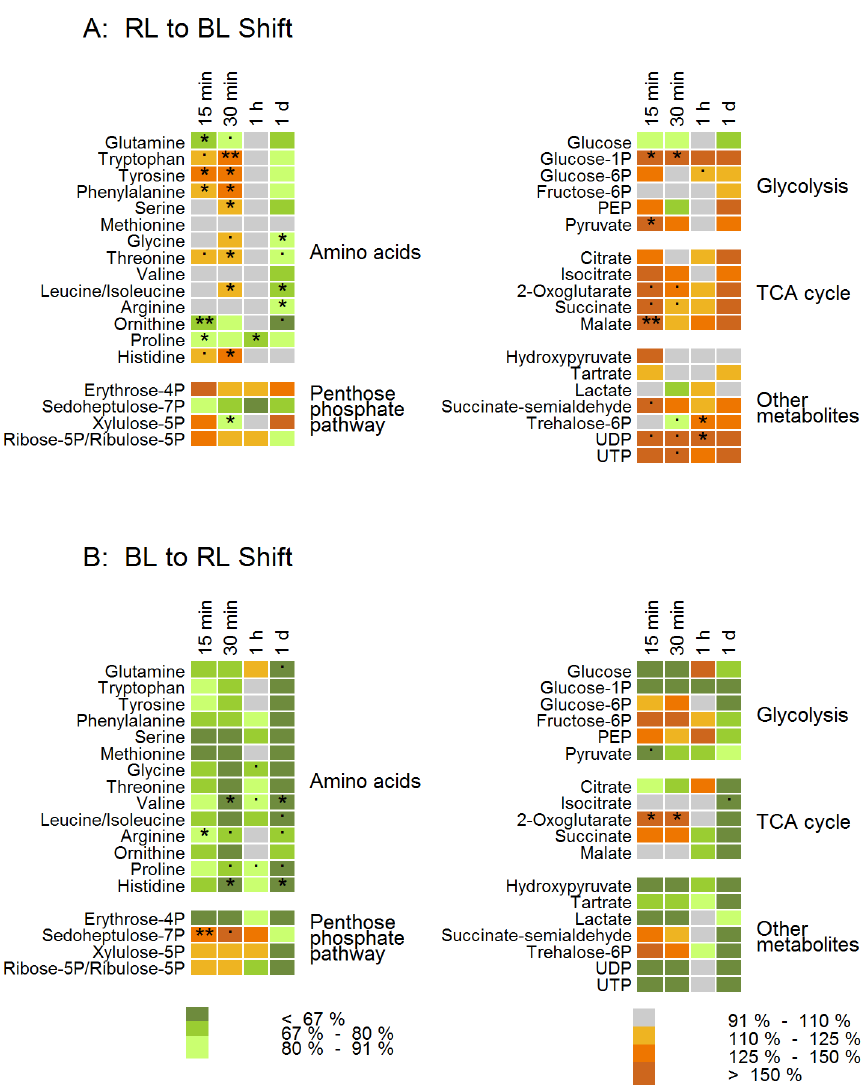
Figure 6. Metabolite profile. The changes in the content of metabolites per cell after a light quality change compared to the pre-acclimated P. tricornutum cultures were determined for 4 time points. The asterisks depict the p-values of the respective data point compared to t 0 . Additionally ‘.’ marks p , 0.1. Significant changes that were lower than 10% (marked grey) were omitted. n=3.